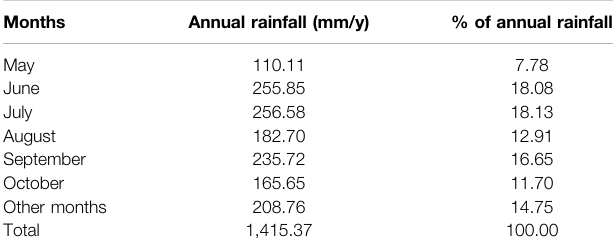
TABLE 1 | The monthly rainfall during the rainy seasons (from May to October) of the study area (information from TMD, 1977 – 2006). Months Annual rainfall (mm/y) % of annual